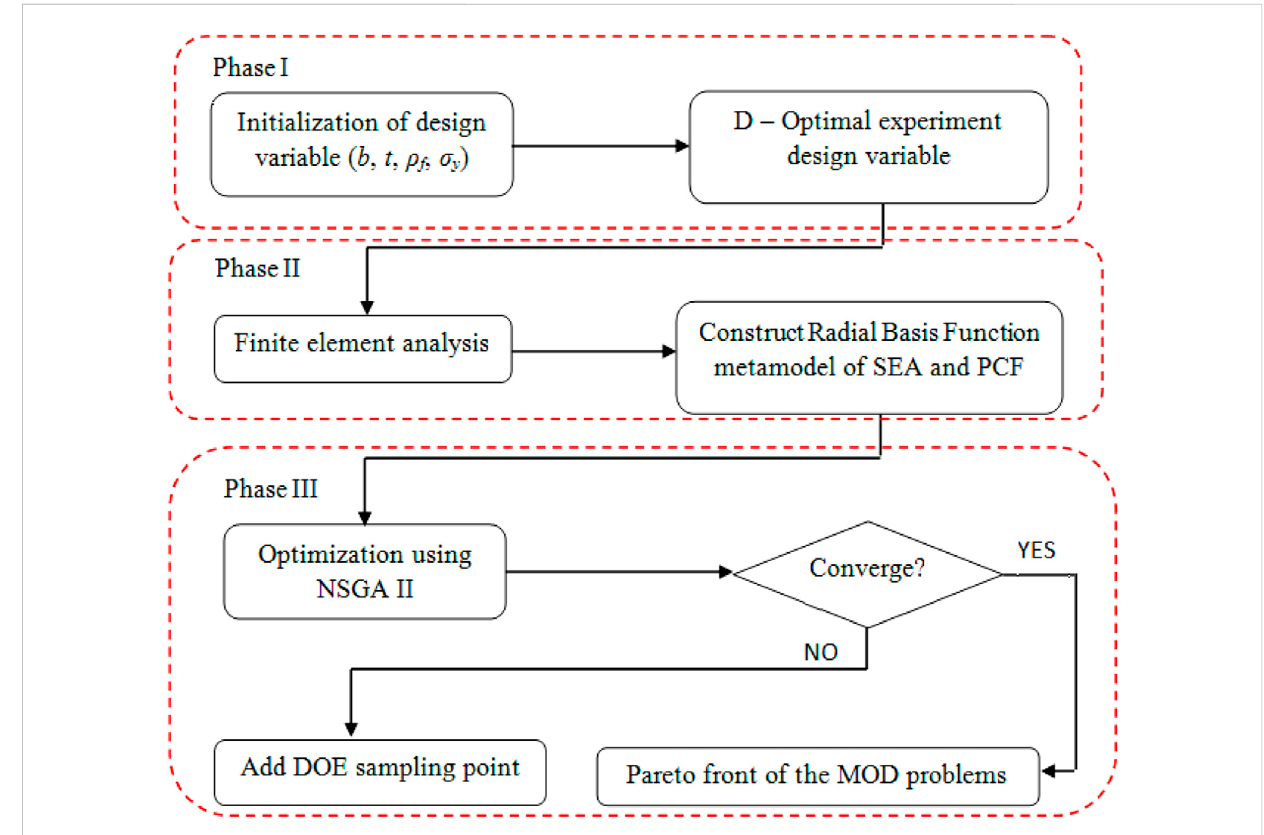
FIGURE 5 Flowchart of crashworthiness multi-objective optimization for tubes